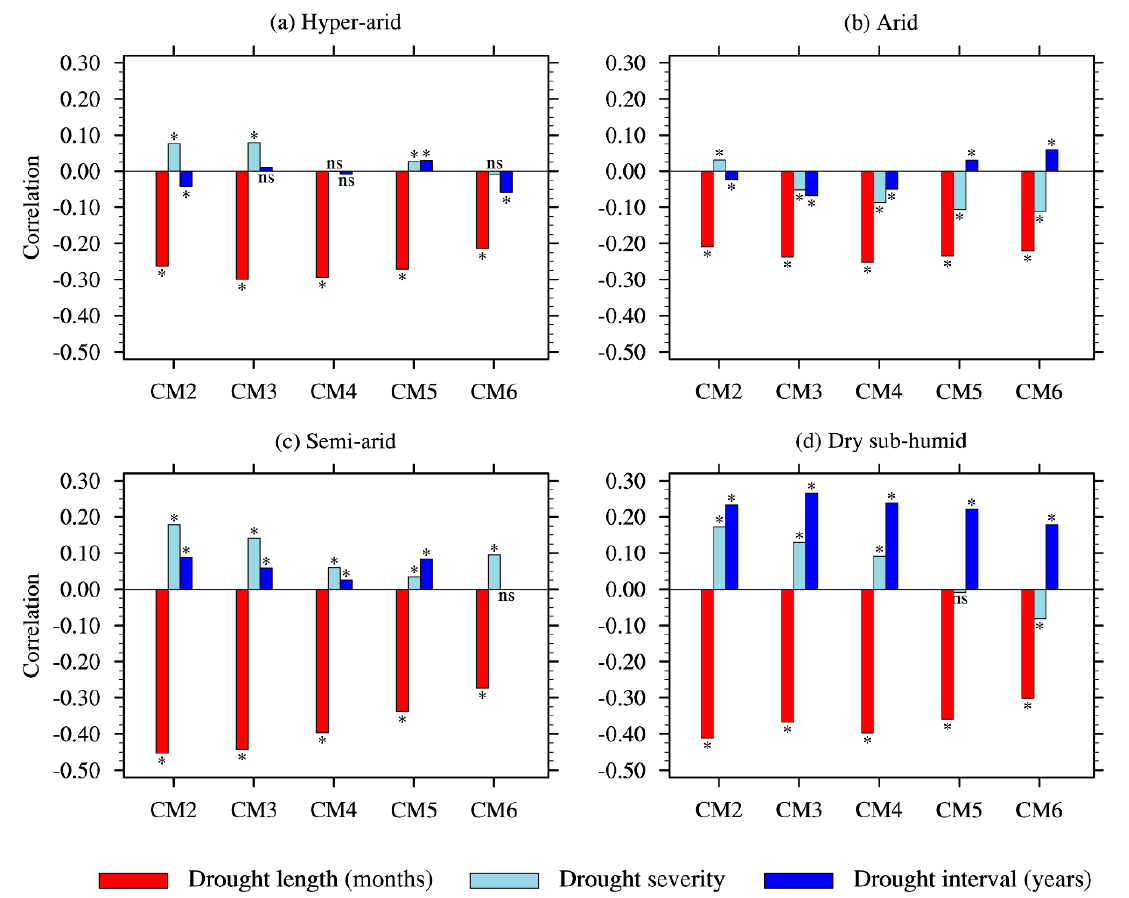
Figure 4. Correlations between resistance and drought characteristics, including drought length, severity, and interval, when the time spent identifying drought events and drought years include durations of 2, 3, 4, 5, and 6 consecutive months in ( a ) hyper-arid, ( b ) arid, ( c ) semi-arid, and ( d ) dry sub-humid regions. * p < 0.05; ns, not significant. CM2, CM3, CM4, CM5, and CM6 represent 2, 3, 4, 5 and 6 consecutive months, respectively.